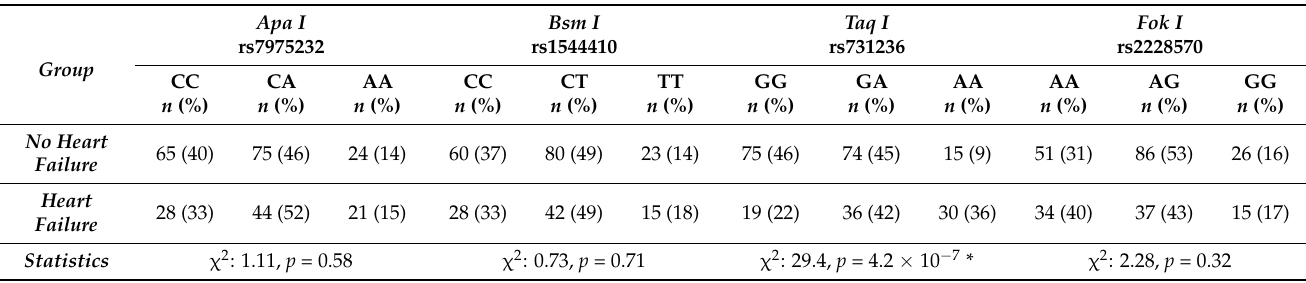
Table 5. Distribution of VDR gene genotypes among Heart failure and non-heart failure groups.